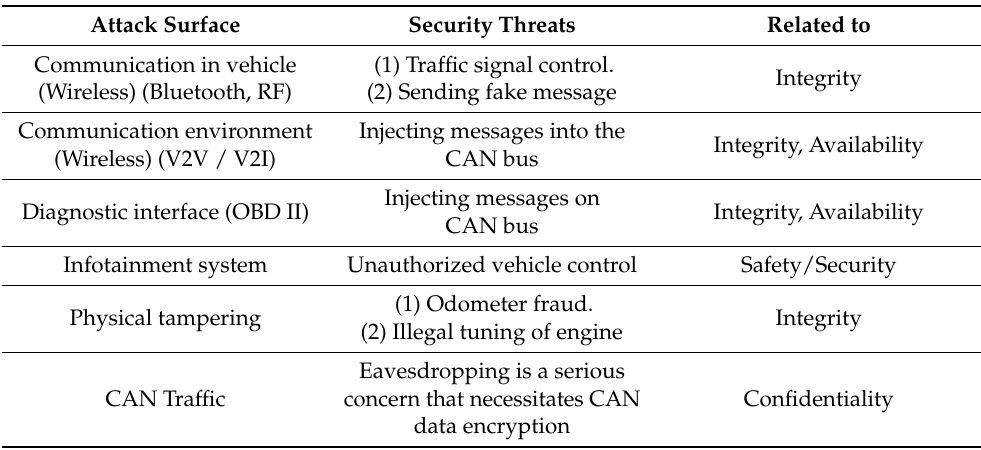
Table 3. Security threats on vehicle electronic